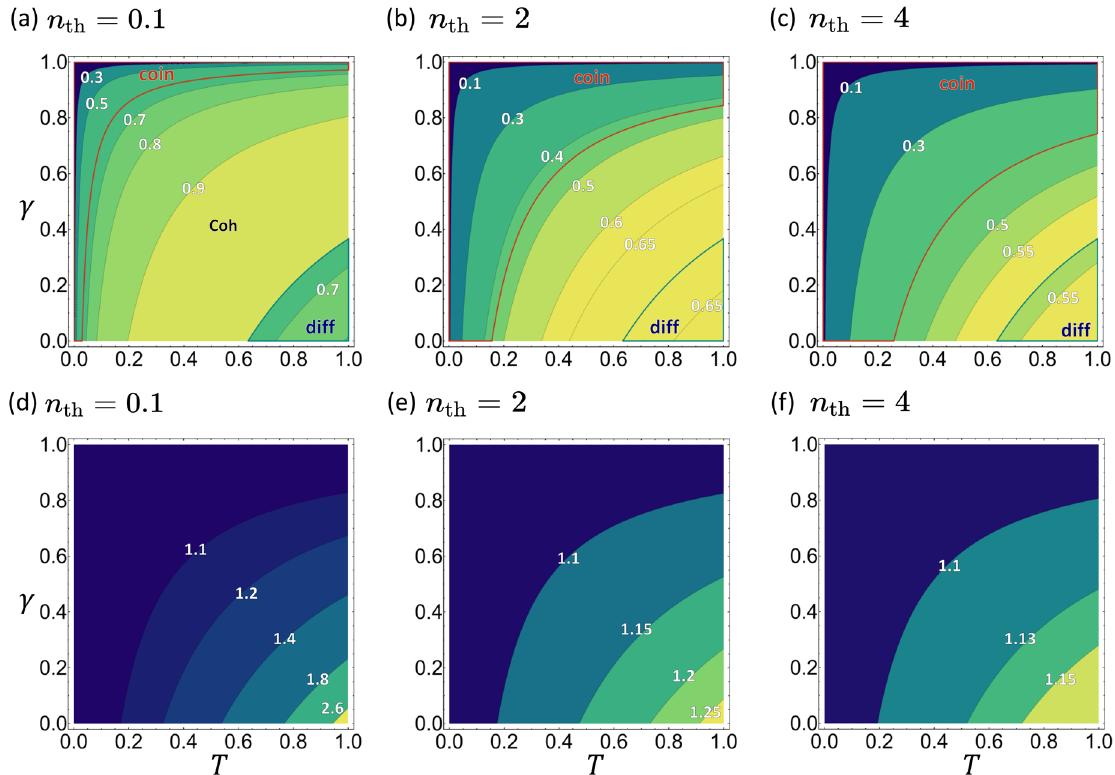
opt Figure 7. Top row: R κ in their respective regions of dominance, for the alternative setup. Bottom row: R QFI , illustrating the upper bound on the achievable quantum